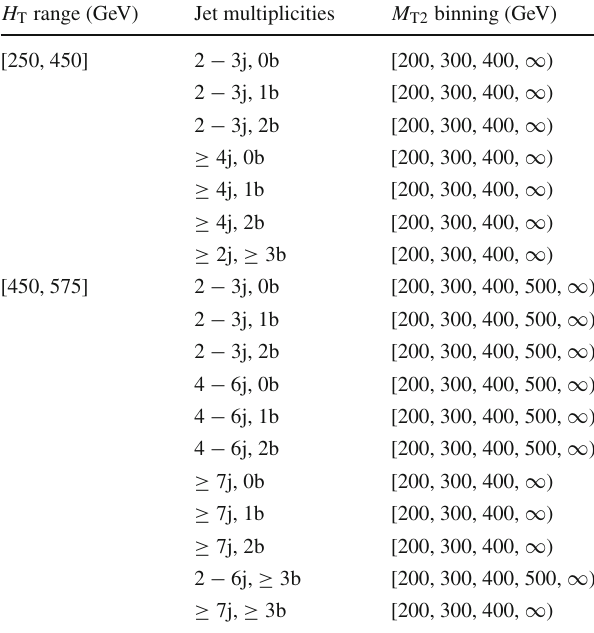
Table 6 The M T2 binning in each topological region of the multi-jet search regions, for the very low, low and medium H T regions H T range (GeV) Jet multiplicities